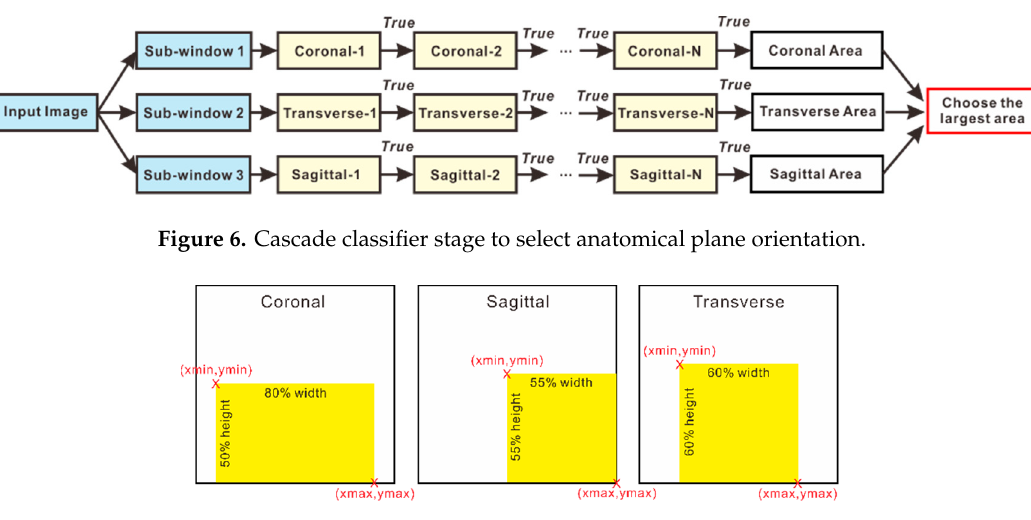
Figure 9. ( a ) Tarsal bone detection; ( b ) Calcaneus region; ( c ) Binary image of calcaneus region; and ( d ) Calcaneus region after morphological operations. Figure 9a shows the selected tarsal bone region using LBP features and cascade classifier. Figure 9b shows the location of the calcaneus determined in accordance with Figure 7 (see Section 2.4). Several morphological operations are applied in the calcaneus region to separate the fractional area. Figure 9c shows the calcaneus region having been converted into a binary image using Otsu